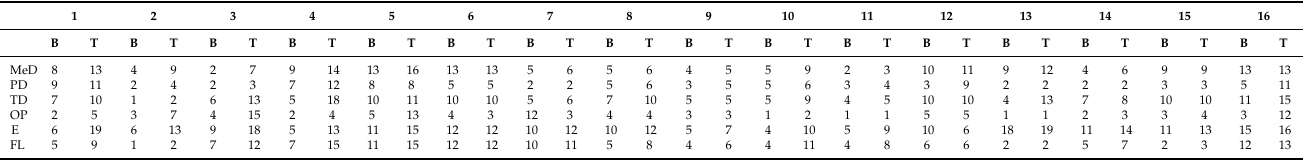
Table 10. NASA-TLX detailed results (Button Task: B; Touch Task: T; Mental Demand: MeD; Physical Demand: PD; Temporal Demand: TD; Own Performance: OP; Effort: E; Frustration Level: FL).